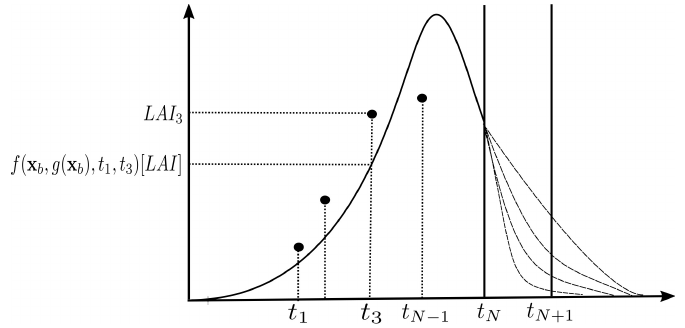
Figure A1. Notations used in the problem formulation. To improve grain yield forecast, both LAI observations from remote sensing (e.g., LAI 3 ) and a simulator function f are used to provide a new model state at the day of forecast t N